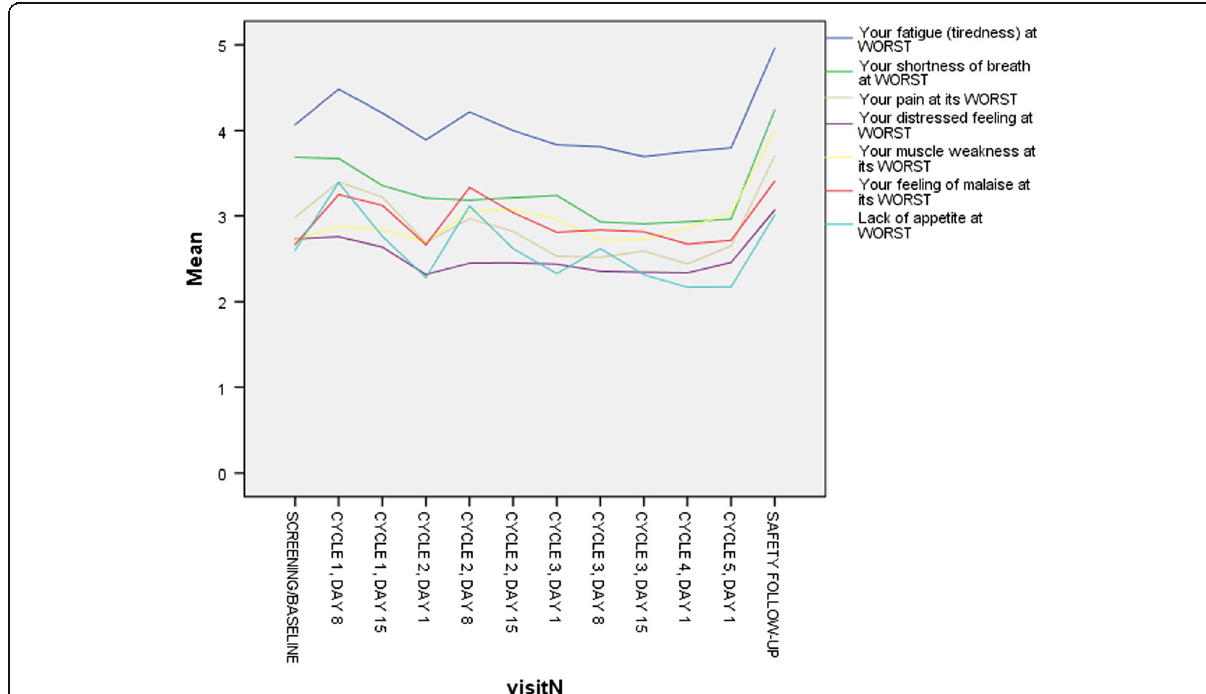
Fig. 1 Symptom severity trajectories over time for the top 7 symptoms (using all available